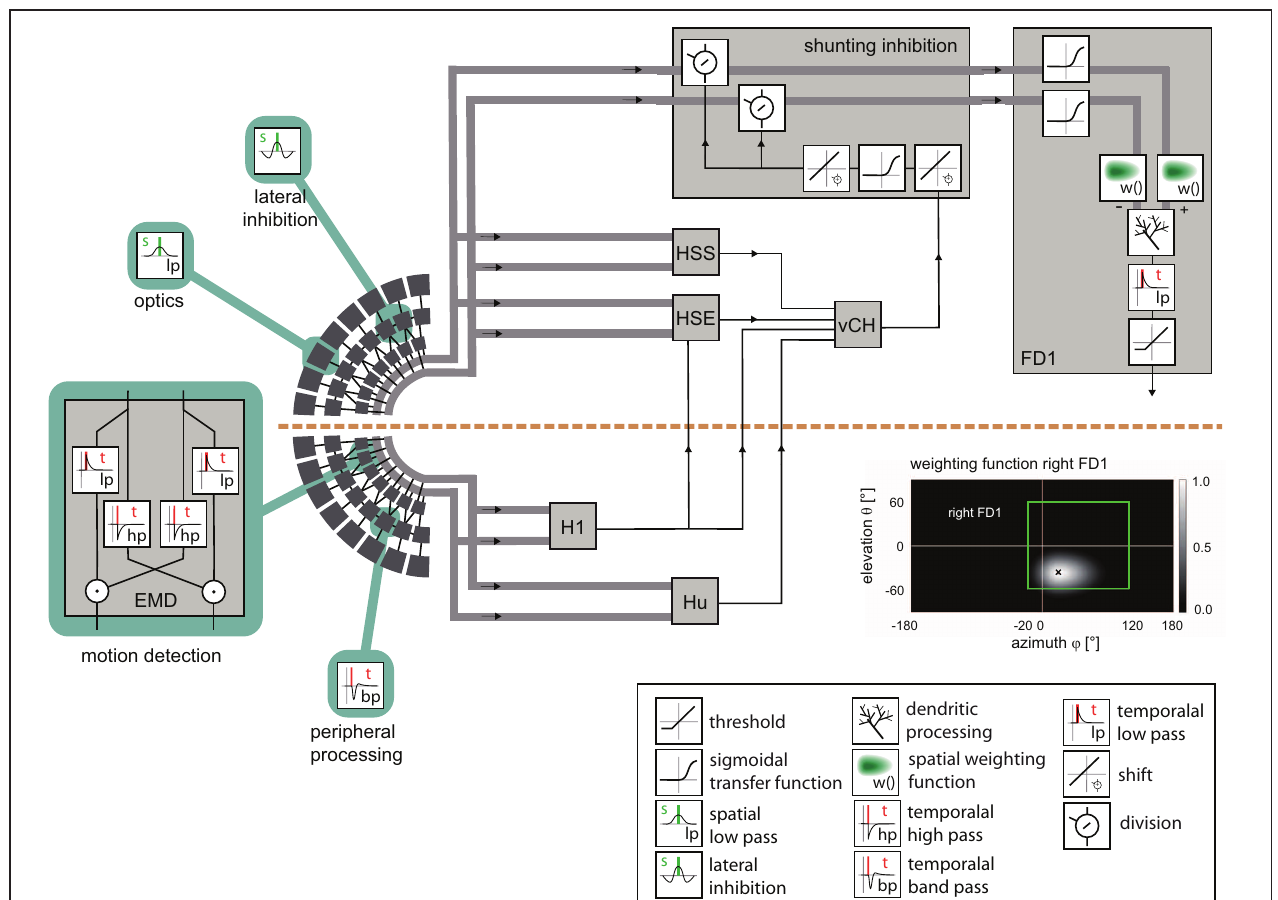
FIGURE 2 | Model of the visual motion pathway of the fly from the eyes to the spatial integration in the lobula plate. A spatial low-pass filter approximated by a two-dimensional Gaussian function (inset) accounts for the optic properties of the ommatidia. The peripheral processing is approximated by an array of temporal band-pass filters (indicated by the impulse response of the filter) followed by a lateral inhibition, together providing the input to an array of elementary motion detectors (EMD) sensitive to horizontal motion. Each EMD is subdivided into two mirror-symmetric subunits with oppositely preferred directions, each consisting of a temporal high-pass filter, a low-pass filter and a multiplication stage. The retinotopic motion information of the half detectors with the same preferred direction is lumped into one channel (broad gray lines). The motion information conveyed by the channels is spatially integrated by the model FD1 and by model cells presynaptic to the vCH cell. The models of the H1, HSE, HSS, Hu, and vCH cells are as developed and tested in a previous study [Hennig et al. (2011)]. The